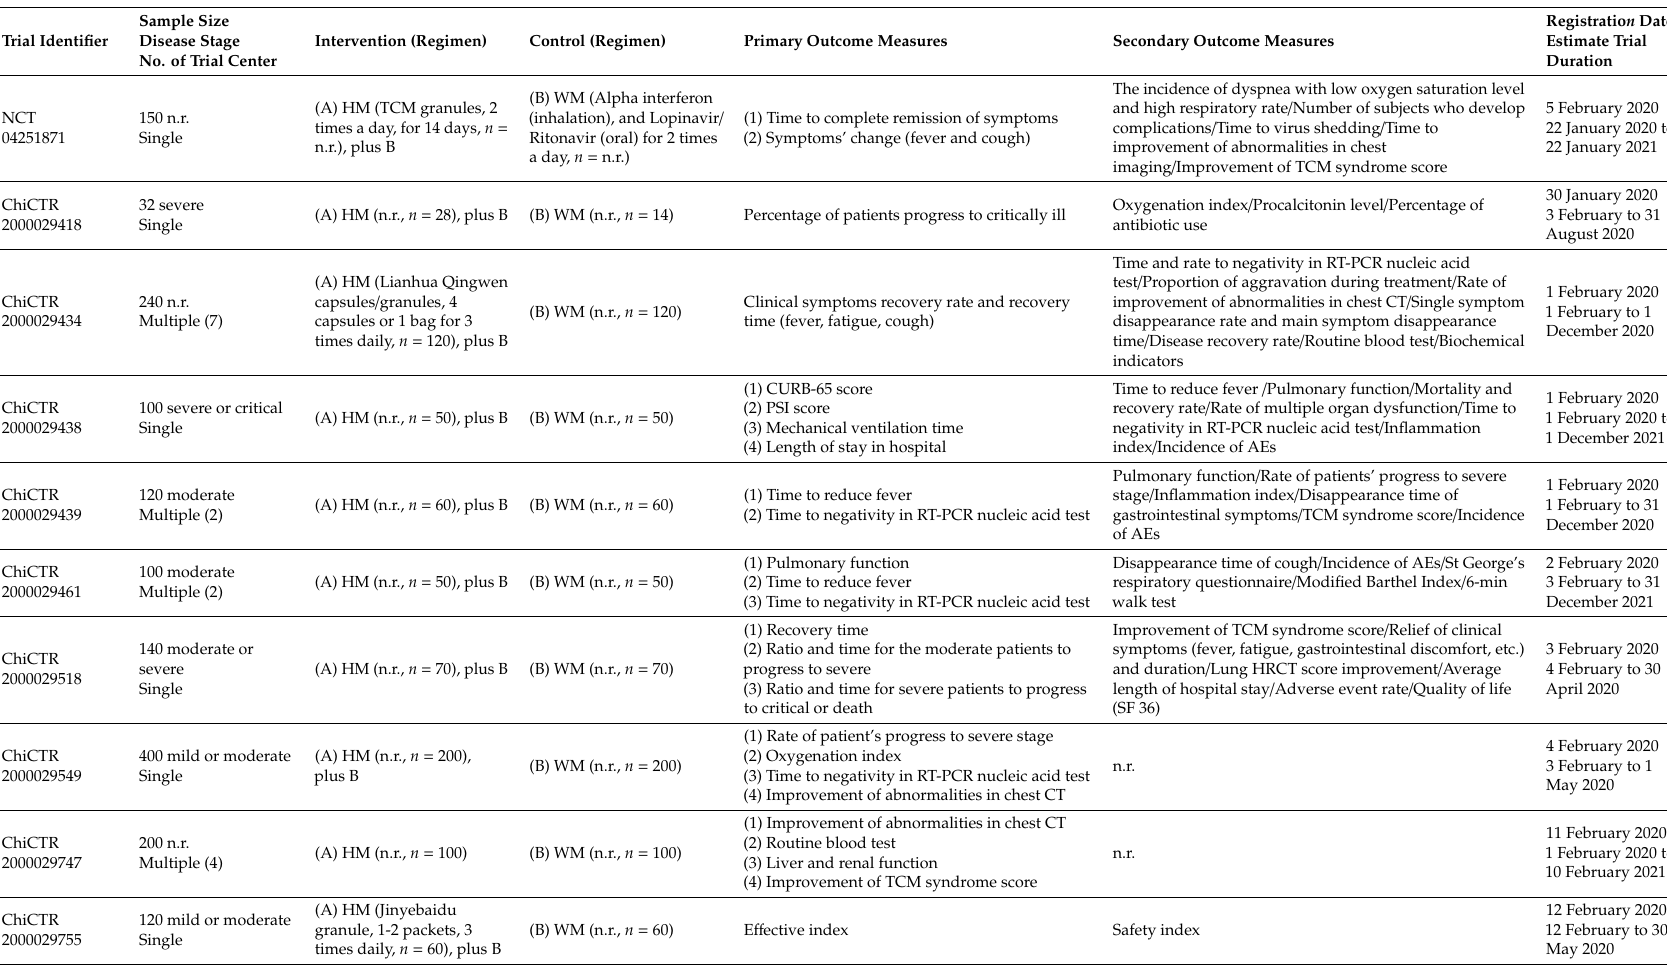
Table 2. Summary of on-going parallel randomized controlled trials (RCTs) studying the e ffi cacy and safety of herbal medicine treatment in patients with